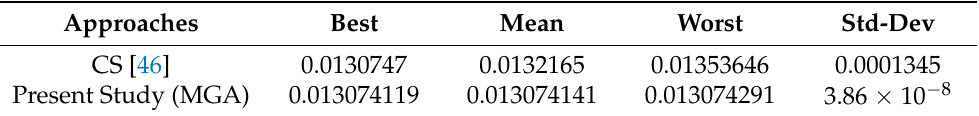
Table 25. Statistical results of different approaches for the steel I-shaped beam design problem. Approaches